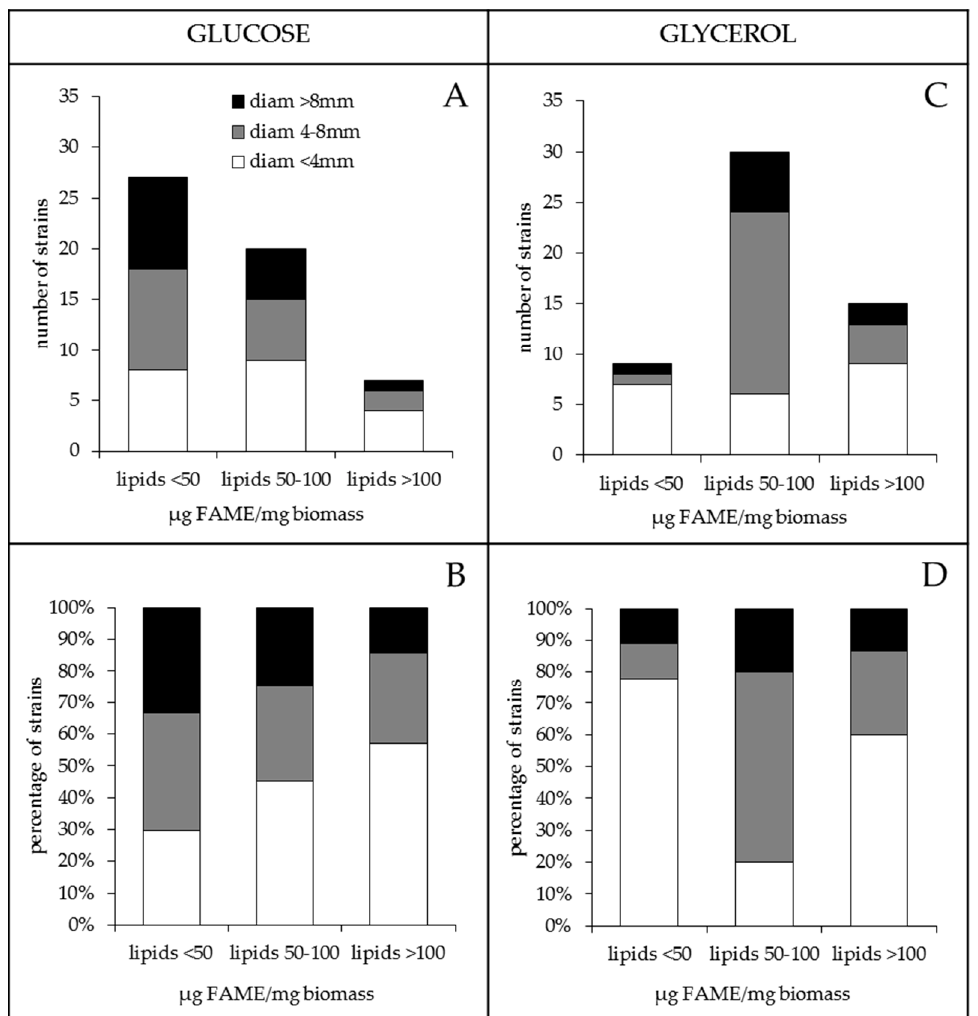
Figure 3. Classification of Streptomyces strains grown for 72 h at 28 °C on solid modified R2YE limited in phosphate, according to low (<50 µg FAME/mg biomass), medium (50–100 µg FAME/mg biomass) or high (>100 µg FAME/mg biomass) total lipid/FAME content, on glucose ( A , B ) and glycerol ( C , D ), respectively. Each lipid class is represented by an histogram, and the numbers ( A , B ) or percentages ( B , D ) of strains with weak (<4 mm), medium (4–8 mm) and strong (> 8 mm) antibiotic activity against Micrococcus luteus correspond to the white, grey and black parts of each histogram, respectively, on glucose ( A , B ) and glycerol ( C , D ).